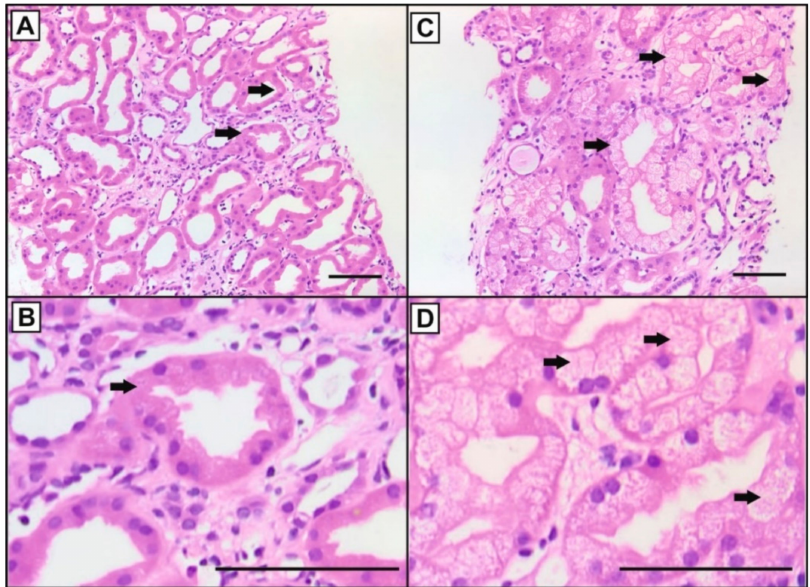
Figure 1. Examples of Hematoxylin and Eosin (HE)-stained sections of kidney transplant biopsies with di ff erent overall scores of isometric vacuolization (arrows) as a marker of calcineurin inhibitor-induced nephrotoxicity. ( A ): < 25% of the tubular epithelial cells, ( B ): magnification of A, ( C ) ≥ 25% of the tubular epithelial cells, and ( D ): magnification of C (bars: 100 µ m).